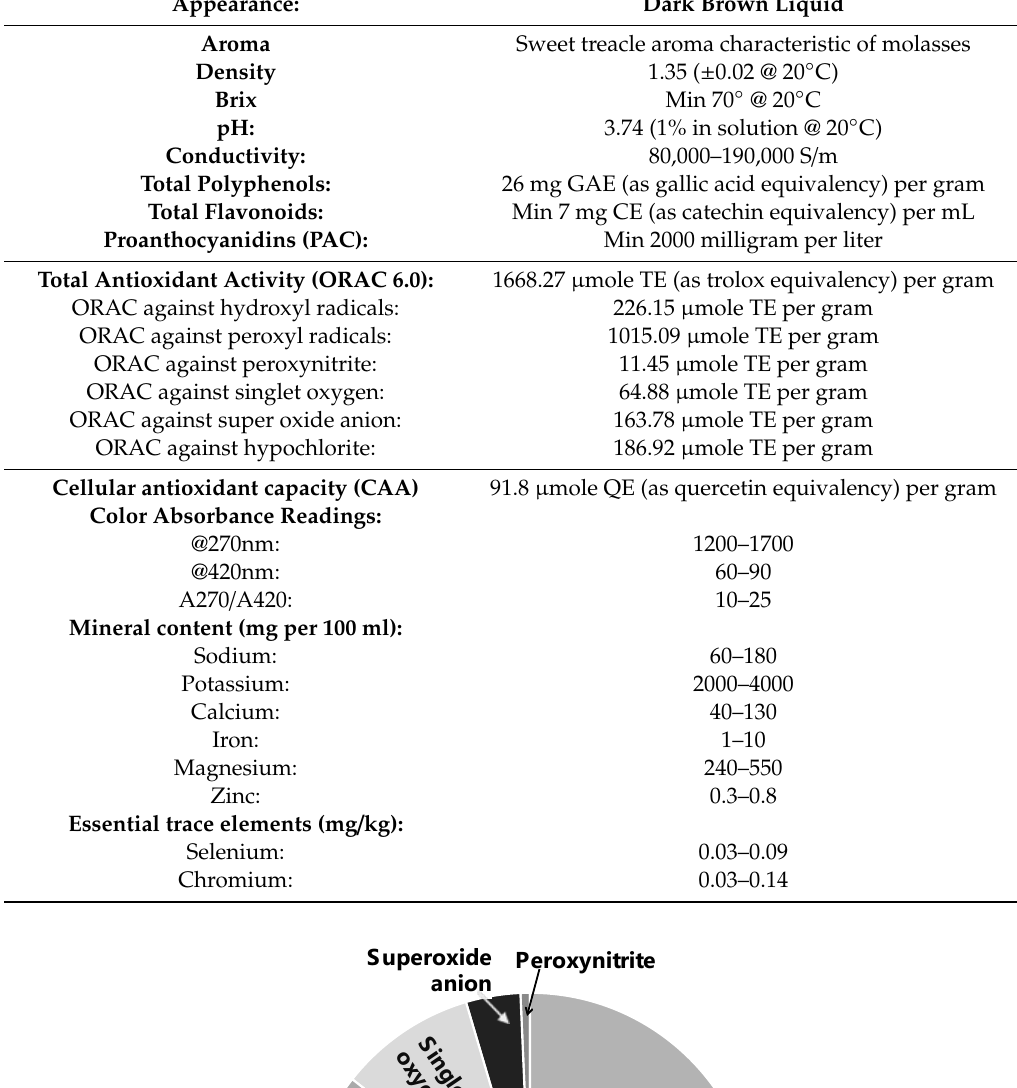
Table 1. Physical Properties of Officinol™.